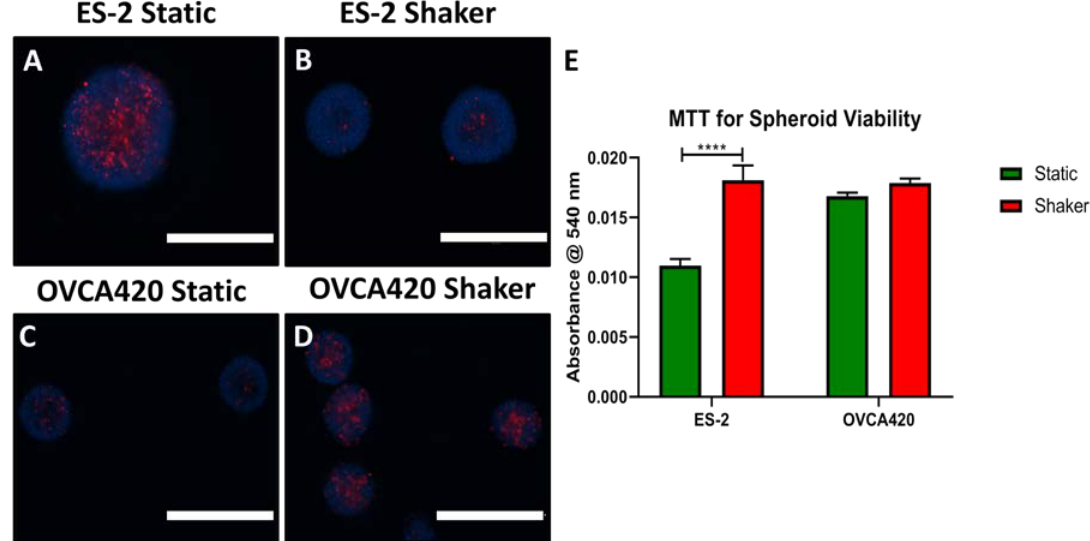
Figure 9. Conservation of spheroid viability following shear stress exposure. Spheroid viability was analyzed in two ways. Cell necrosis was visualized using propidium iodide (red) staining versus Hoechst (blue). Scattered necrotic cells are seen in most spheroids near the center and at the edge under both static ( A, B ) and shaker ( C, D ) conditions. ( E ) Quantification of spheroid viability using the MTT assay. There was no significant difference in cell viability with both conditions. Scale Bar: 400 µm. ( n = 3).